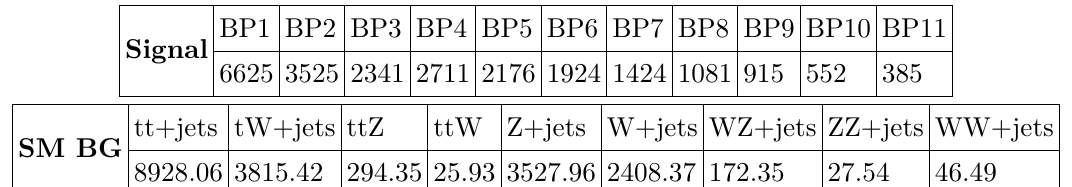
Table 6. The expected number of signal and SM background events after applying M J M J > 120 GeV and b-tag (within leading or subleading fatjet), /E 1 preselection cuts at 14 TeV LHC for 139 fb − 1 integrated